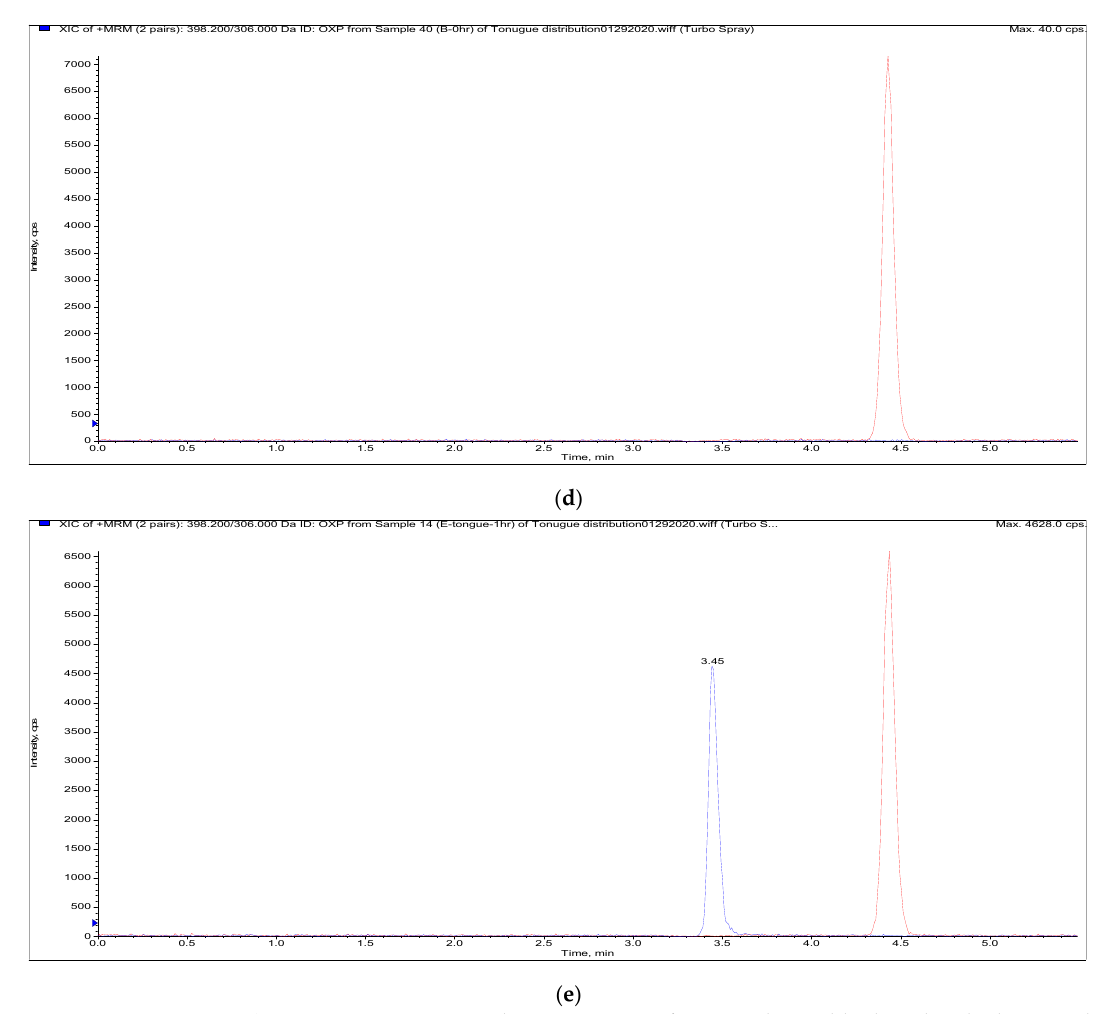
Figure 4. Representative chromatograms of OXP and IS in blank and spiked tongue homogenates: ( a ) blank tongue homogenates, ( b ) OXP spiked in tongue homogenates at the lower limit of detection (5 ng/mL), ( c ) OXP spiked in tongue homogenates at the lower limit of quantification (10 ng/mL), ( d ) blank tongue homogenates spiked with internal standard, ( e ) rat tongue sample at 1 h following patch application. OXP transition depicted in blue and IS transition depicted in red.